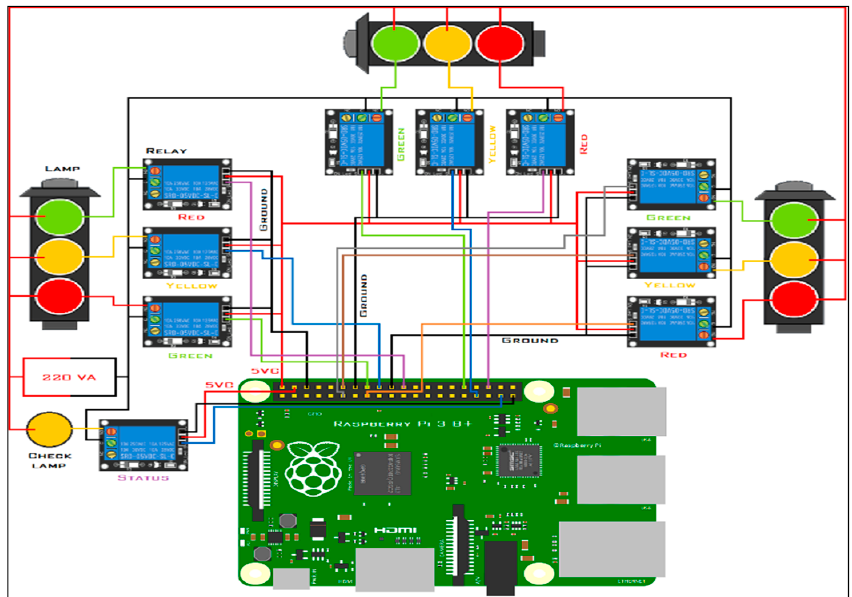
Figure 4. Local controller and connections with traffic lights.